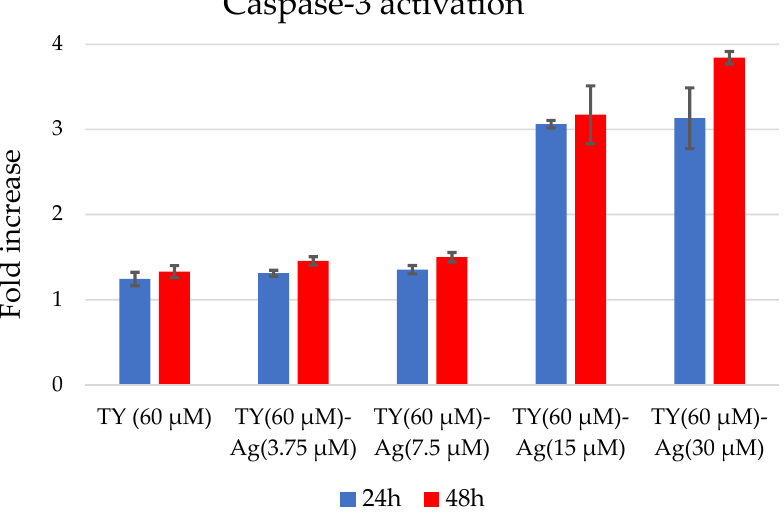
Figure 13. Caspase-3 activation after 24 and 48 h in T24 cells after TY-Ag stimulation.